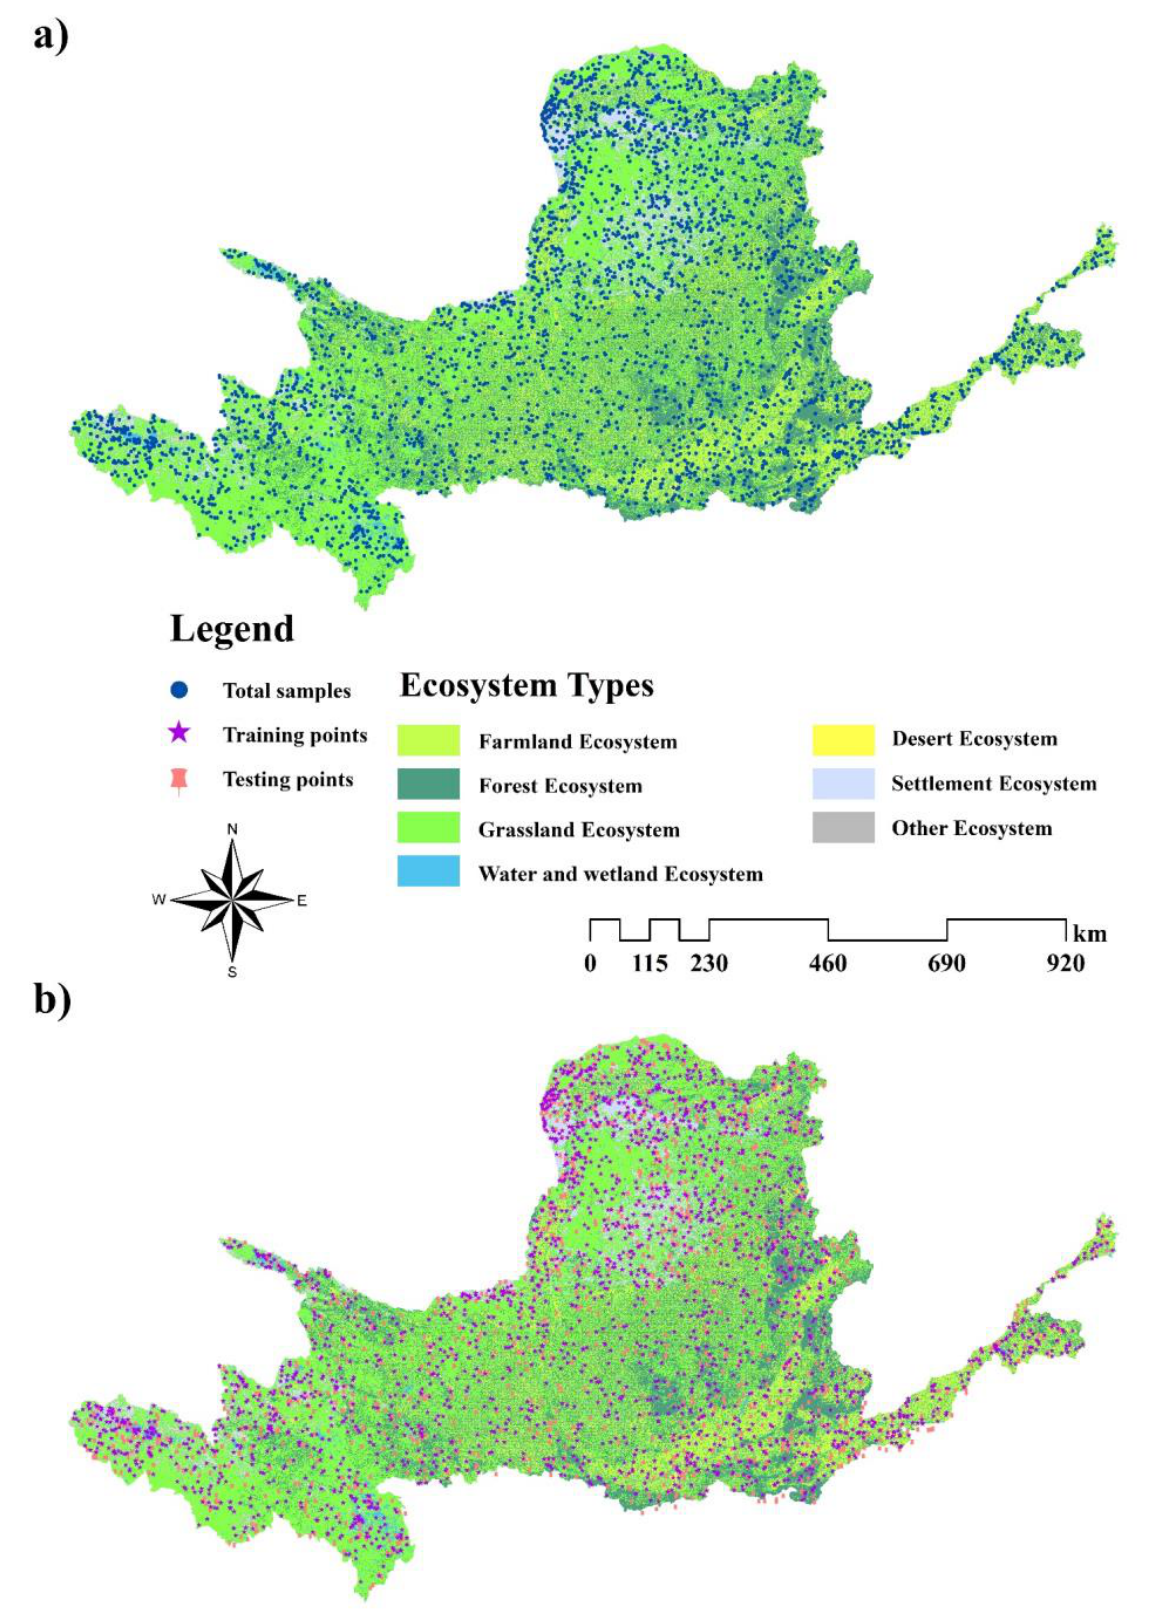
Figure 2. The spatial distribution of sample points: ( a ) illustrates all samples and ( b ) illustrates the training (70%) and testing (30%) points.